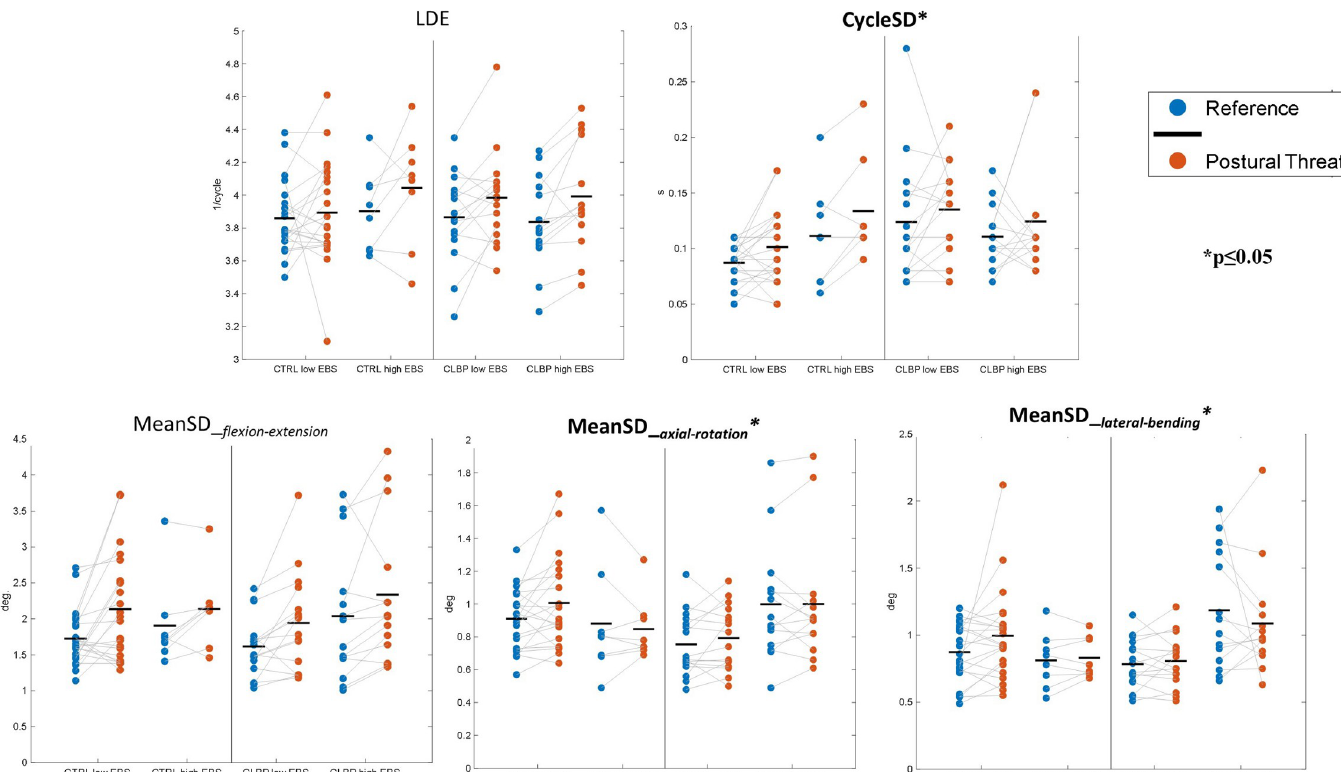
Fig 4. Between-subject effect: Lumbar movement characteristics during repetitive seated reaching (40x) in the reference- and threat-conditions. Dots represent individual participants grouped based on CLBP and EBS, horizontal lines represent the group means.